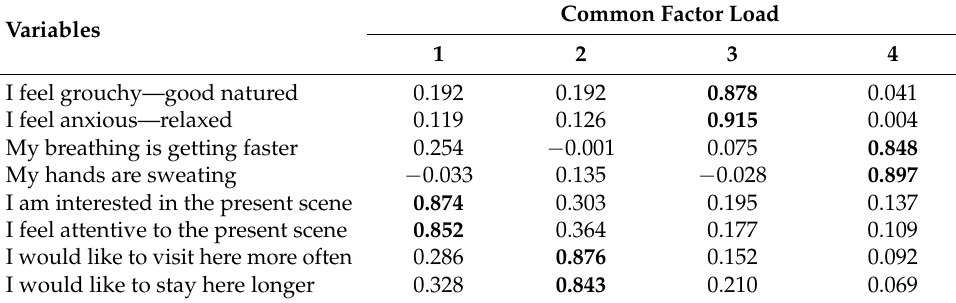
Table 5. The factor load matrix of SRRS after